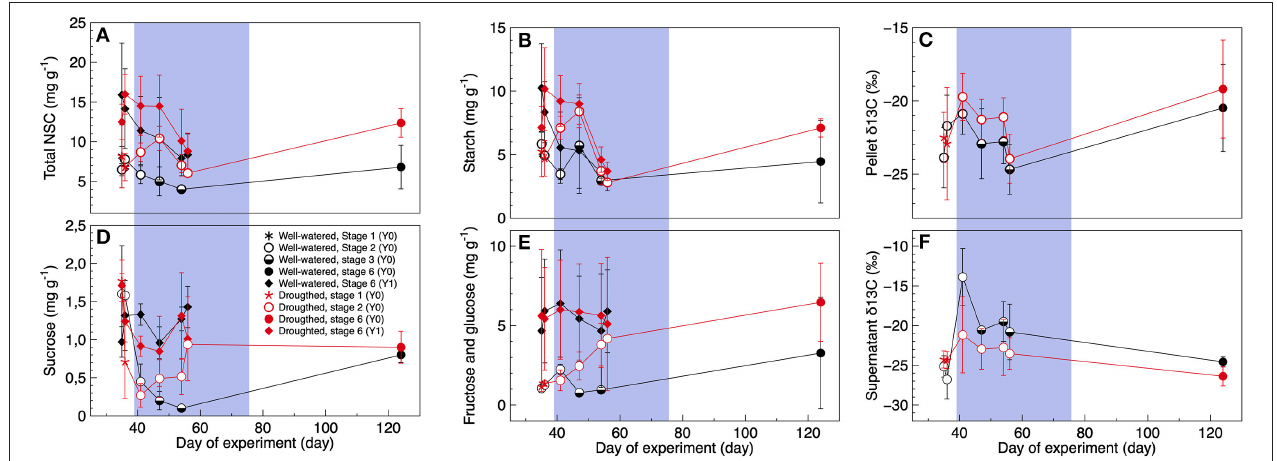
FIGURE 3 | (A,B,D,E) Non-structural carbohydrate concentrations and (C–F) their natural abundance of 13 C, in black spruce for current-year (Y0) and 1-year old shoots (Y1) when trees are well-watered (black symbols) or exposed to a temporary drought period (red symbols). Developmental stages: 1 (stars), 2 (open circles), 3 (half-filled circles), and 6 (filled circles). One-year old shoots were all classified as stage 6 (filled diamonds). For the non-structural sugars, the pellet is a proxy for starch whereas the supernatant contains highly soluble sugars as sucrose, fructose, and glucose. The blue color indicates the 40-day long drought period. Mean ± 1SD, n = 2–3